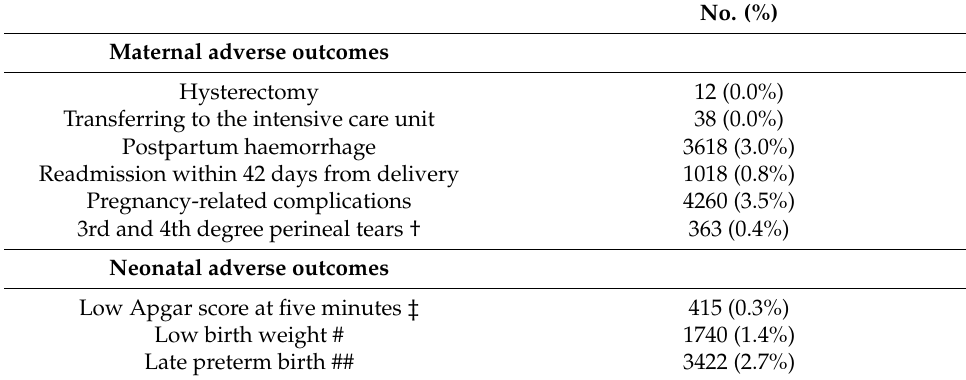
Table 2. Maternal and neonatal adverse outcomes experienced from the 122,563 mother-newborn pairs included into the study cohort. Italy, region of Lombardy,